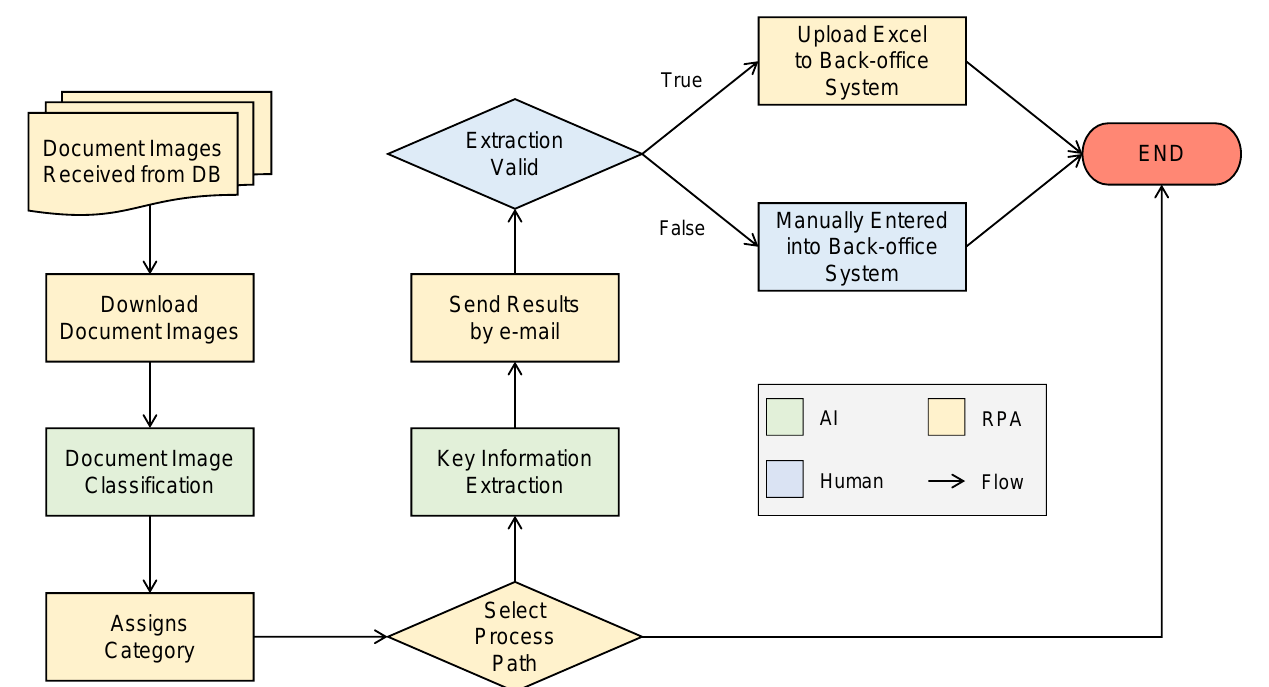
Figure 3. Overall architecture of the proposed framework for unstructured financial document image processing.